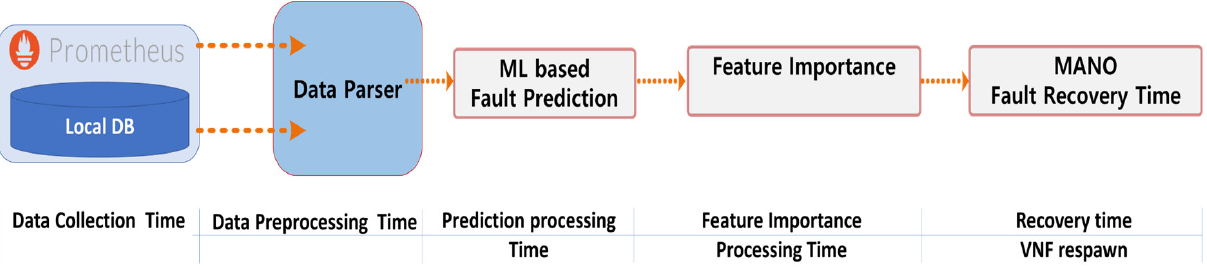
Figure 4. Workflow of Fault Recovery.